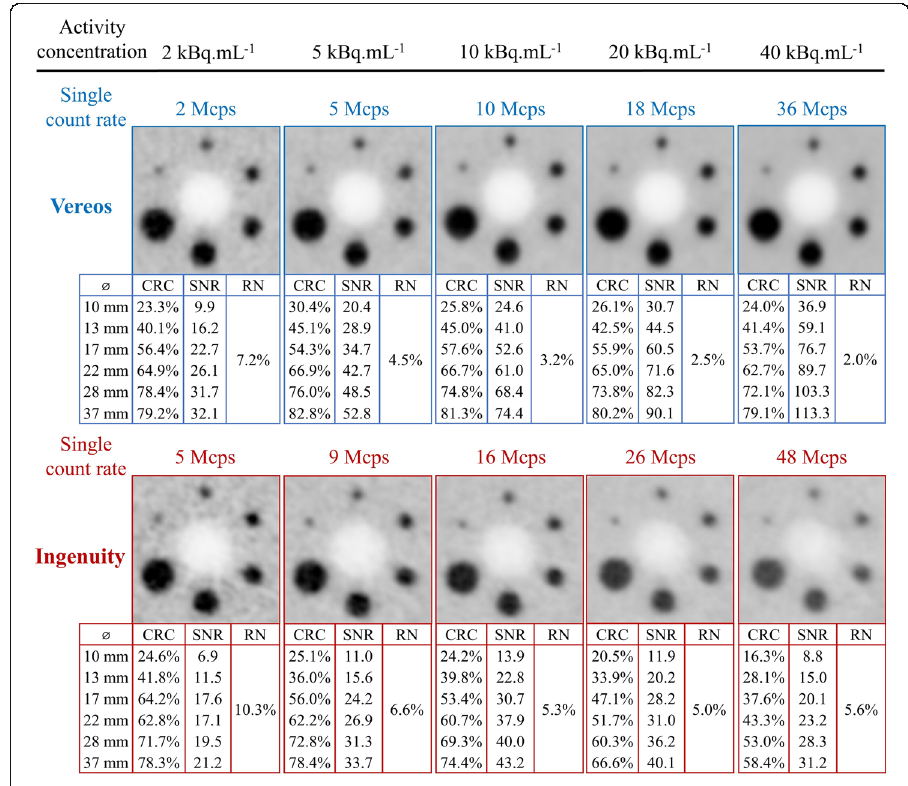
Fig. 5 Representative examples of PET slices of the IEC phantom recorded with the TOF information with the Vereos (upper panels) and the Ingenuity (lower panels) at count rates corresponding to the same levels of activity concentrations for both cameras (i.e., at background concentrations of the IEC phantom of 2, 5, 10, 20, and 40 kBq.mL -1 ). The values of signal-to-noise ratio (SNR) and contrast recovery coefficients (CRC) for the 10 to 37-mm diameter hot spheres are inserted in each image, together with the background relative noise